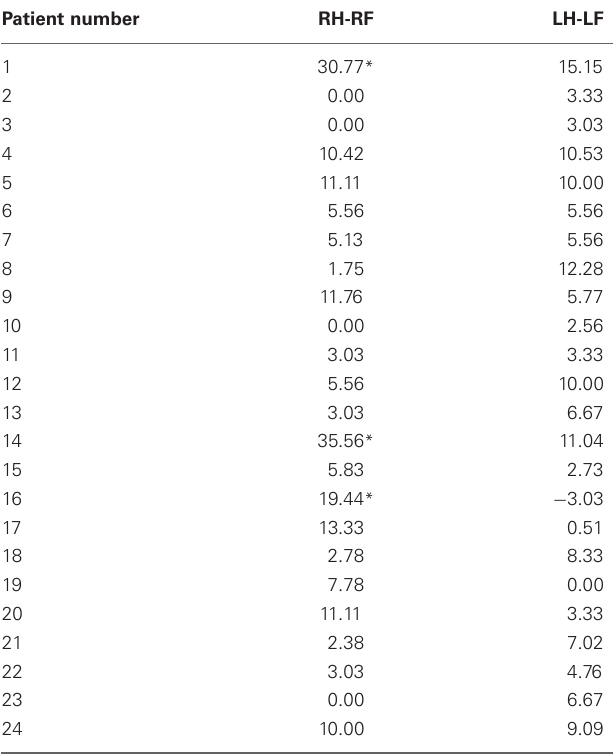
Table 4 | Difference values of the percentage error scores of CA patients for congruent